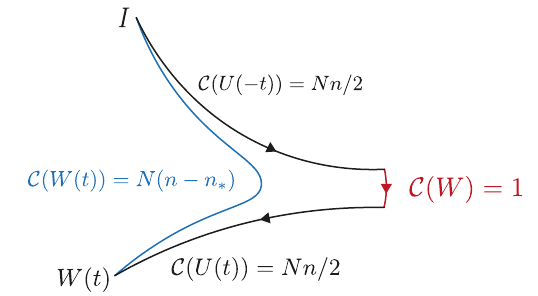
Fig. 6 Illustration of the evolution of the complexity of the precursor as a geodesic deviation in negatively curved